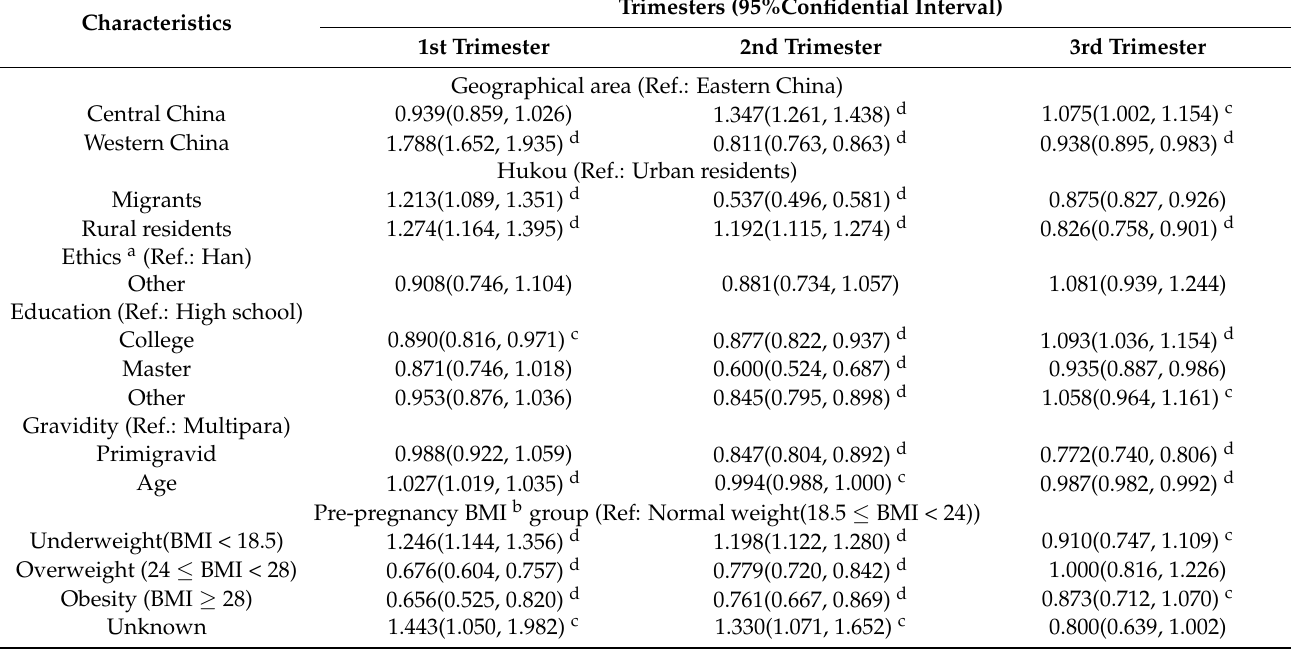
Table 7. Associations between basic characteristics and the anemia prevalence in pregnant women according to